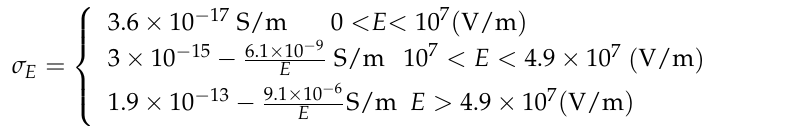
radiation is shown in Figure 7.